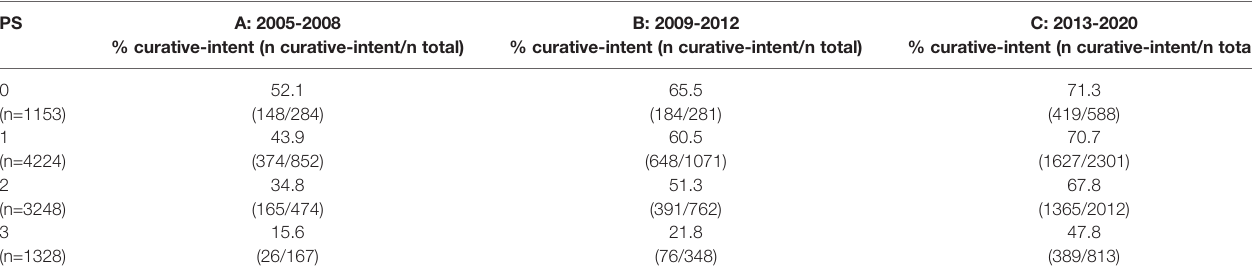
TABLE 2 | Proportion of patients treated with curative-intent radiotherapy across each PS and time period. PS